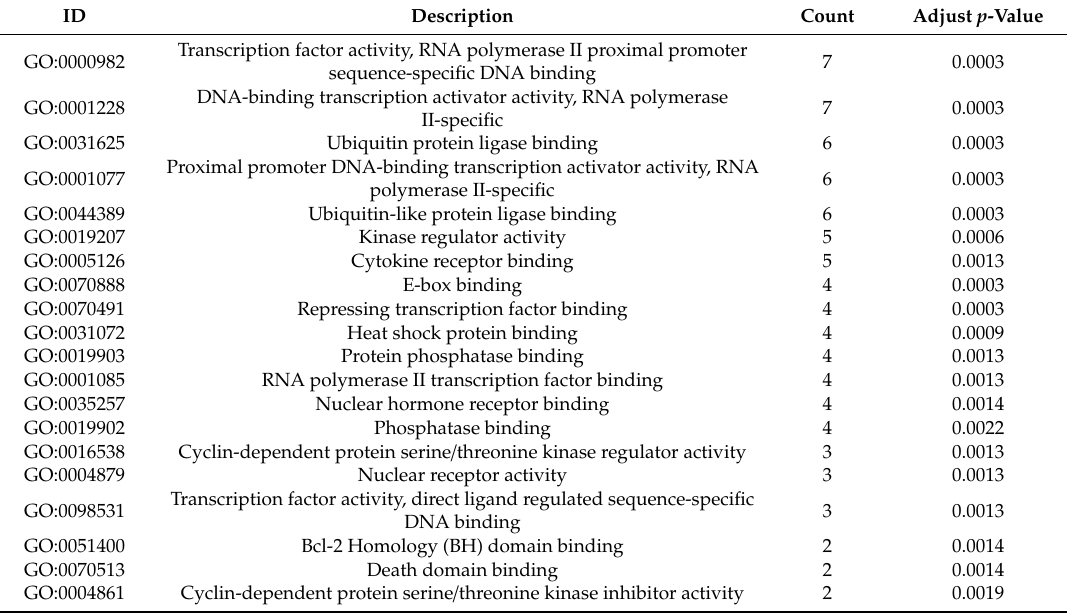
Table 3. Enrichment